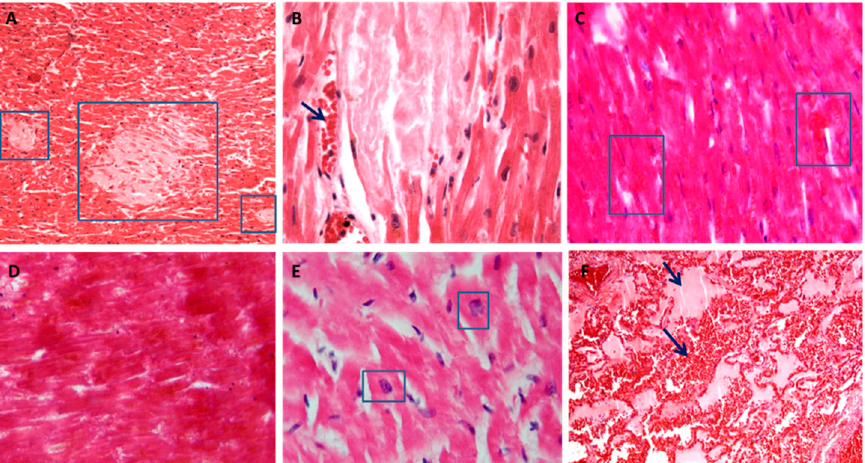
Figure 4. The heart and lung histology from high voltage electrocution. Different localizations of necrosis. ( A , B ): multiple and diffuse foci in the absence of inflammatory infiltrate (blue box indicates the detail) with erythrocyte extravasation (black arrow indicates the detail) (H&E stain × 10 in A , × 40 in B ). ( C , D ): large areas of coagulative necrosis with loss of nuclei and with erythrocyte extravasation in ( C ) (blue box indicates the detail) (H&E stain × 10). ( E ): fragmentation of myofibers with enlarged and distorted nuclei (blue box indicate the detail) (H&E stain × 40). ( F ): pulmonary intra-alveolar edema and hemorrhage (black arrow indicates the detail) (H&E stain × 10).